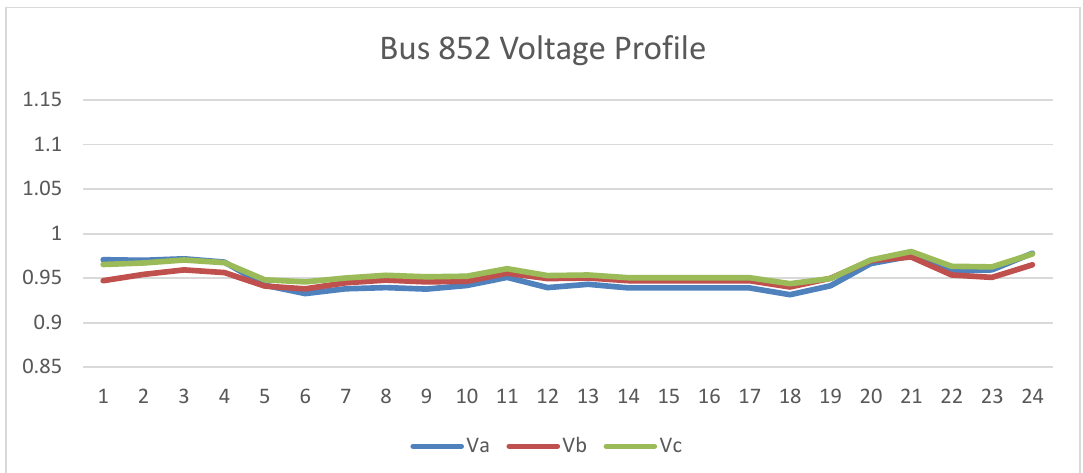
Figure 9 . Case 2 Spot Buses 844 and 890 Additional Loads (kW).